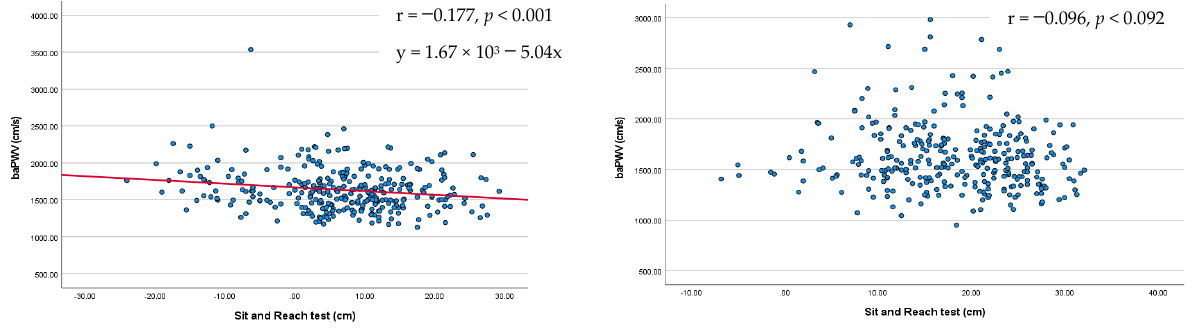
Figure 1. Association between baPWV and the sit-and-reach test: male/female participants’ results, expressed as scatter plots. Blue dots: individual data point. Red line: linear relationship between baPWV and sit-and-reach test result. baPWV, brachial–ankle pulse wave velocity.